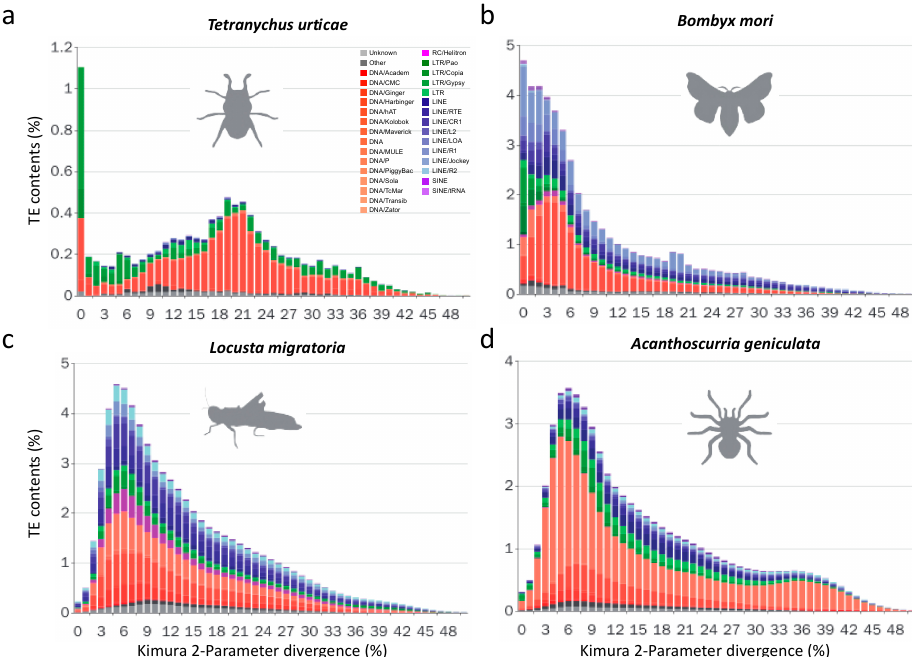
Figure 2. Sequence divergence distribution of TEs. ( a – d ) Distribution of sequence divergence of multiple TE subfamilies in four species. The y-axis shows the percentage of the host genomes that is annotated as TEs (TE contents). The x-axis shows Kimura 2-Parameter sequence divergence between individual TE copies and consensus references. Unknown, unclassified TEs; Other, Retro and Retroposon.